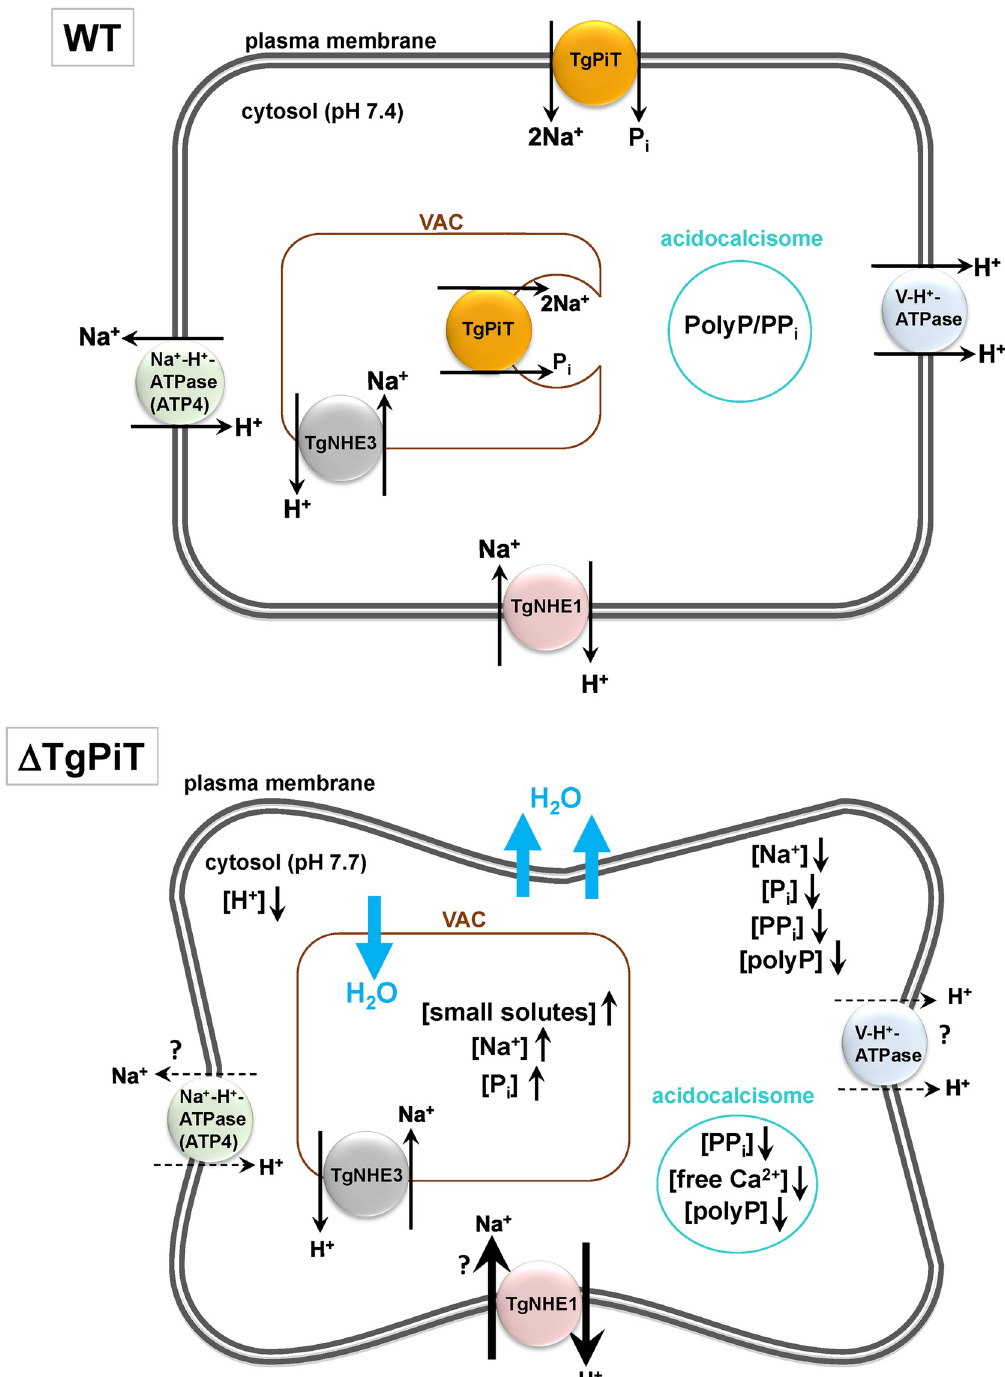
Fig 14. Hypothetical model for ion homeostasis and osmoregulation in Toxoplasma . Na + homeostasis in Toxoplasma is accomplished via cooperation between ATP4, TgNHE1 and TgPiT. When intake of Na + is reduced through TgPiT ablation, compensatory mechanisms may include decreased activity of ATP4 (dashed arrows) and increased activity of TgNHE1 (thick arrows), both resulting in reduced H + concentrations in the parasite and thus cytosolic alkalinization. Consequently, the mutant decreases the export of H + mediated by V-H + -ATPase (dashed lines). Δ TgPiT parasites have a severe constitutive loss in cytosolic ionic strength through reduced internalization of P i and sodium into the parasite and impaired expulsion of these ions from VAC into the cytosol. Due to low P i availability, the mutant has reduced concentrations of total P i and polyP that is compensated for increased numbers of acidocalcisomes in an attempt to garner as much phosphate as possible.